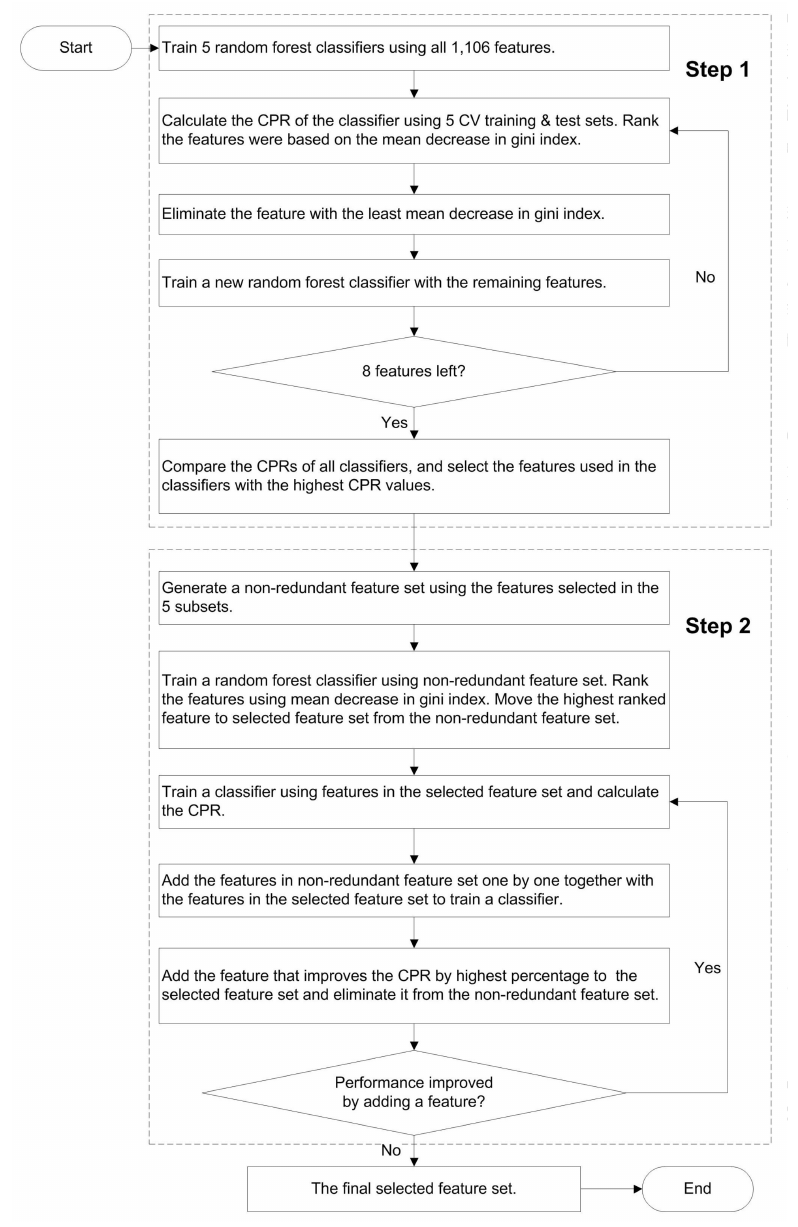
Figure 2. The procedure for feature selection. CPR, correct prediction ratio; CV, cross